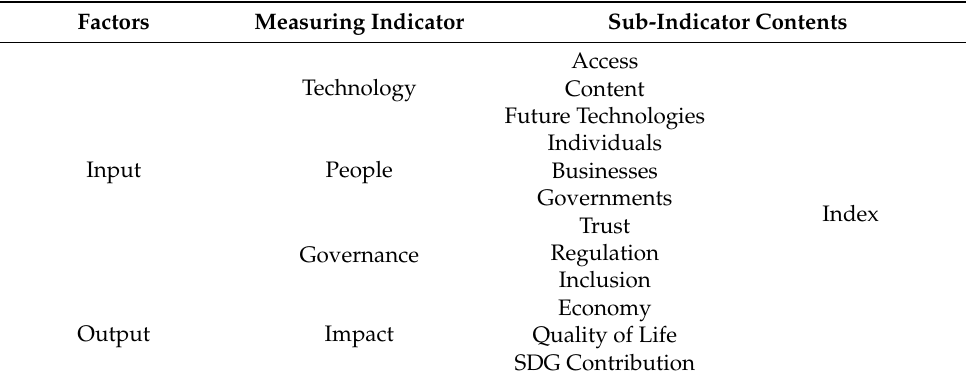
Table 2. Operational definition of